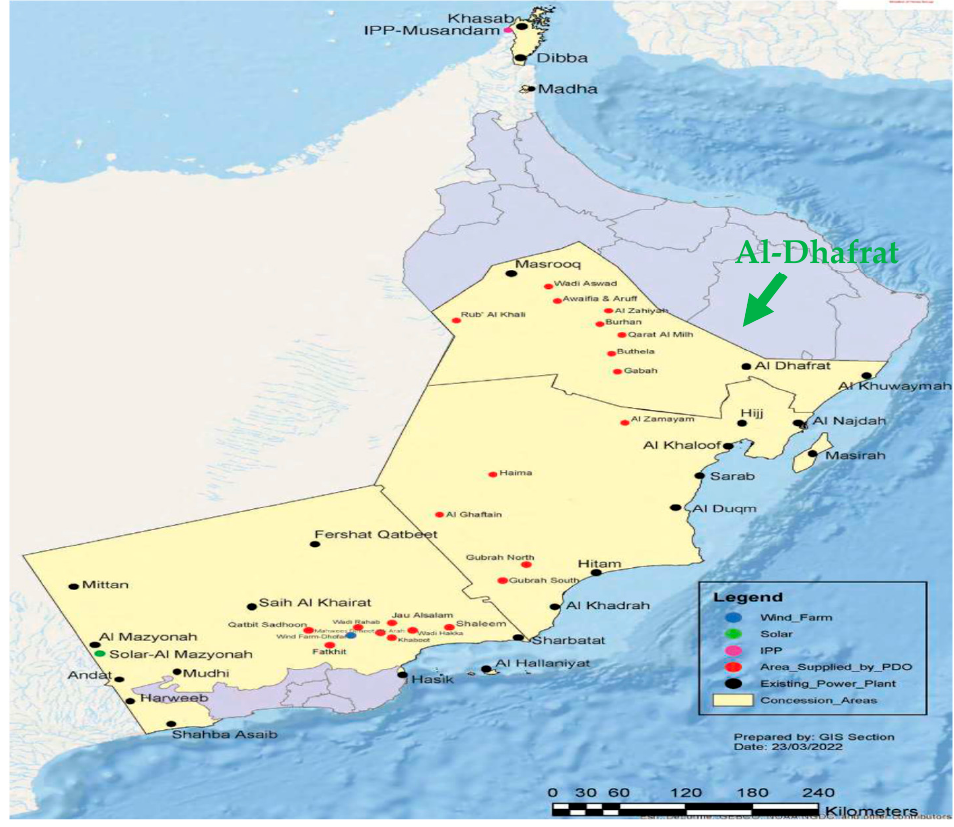
Figure 2. Location of Al-Dhafrat community in the Sultanate of Oman [4].